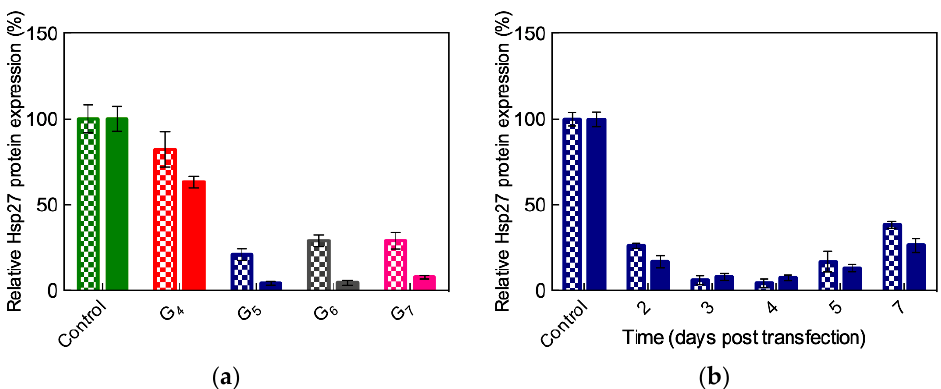
Figure 10. ( a ) Hsp27 gene silencing upon delivery of complementary ssiRNAs mediated by different generations of TEA-core PMAMAM to PC-3 cells. Checked bars: Data for A 5 / T 5 ssiRNA; solid bars: Data for A 7 / T 7 ssiRNA. In these experiments, vinculin was used as reference and non-treated cells were used for control. ( b ) Long-term Hsp27 silencing achieved with A 5 / T 5 and A 7 / T 7 ssiRNAs (50 nM) delivered by G 5 TEA-core PAMAMs at N / P = 10. Redrawn from [56], with permission of the American Chemical Society.